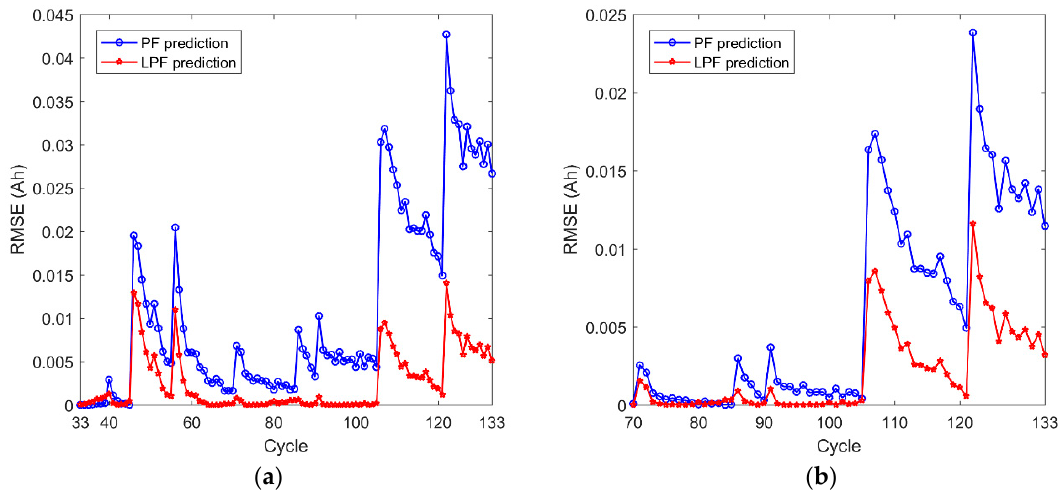
Figure 9. Histograms of predicted RUL distribution for battery B18, using 100 particles and 70 observations for the PF and the LPF methods: ( a ) PF; ( b ) LPF.